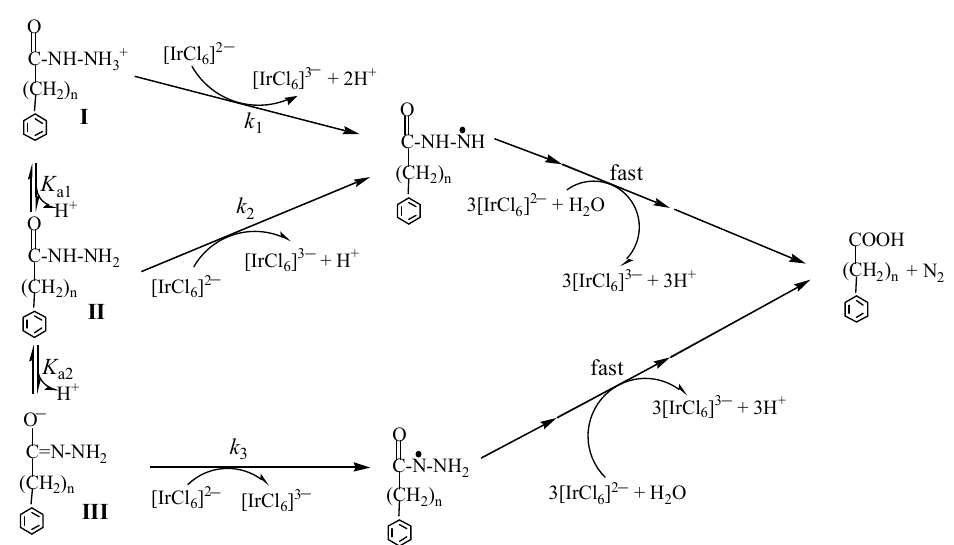
Figure 7. A reaction mechanism proposed for the oxidations of BH ( n = 0) and PAH ( n = 1) by [IrCl6] 2 − in which the reactions described by k 1 – k 3 are the rate-determining steps.